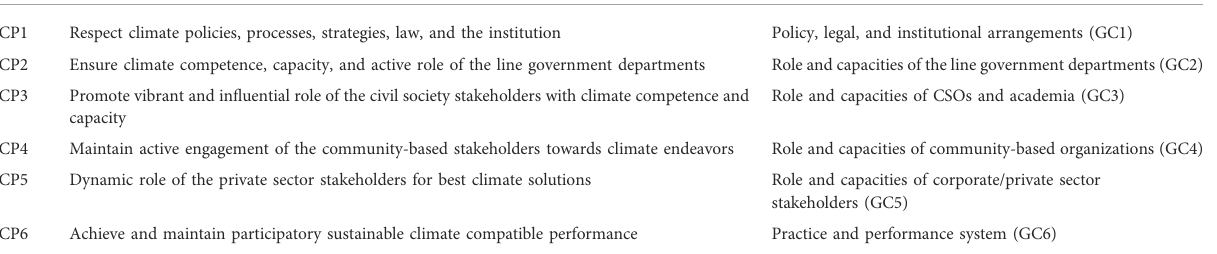
TABLE 1 Climate response principles and components of the basic governance mechanism (Iqbal et al., 2022).